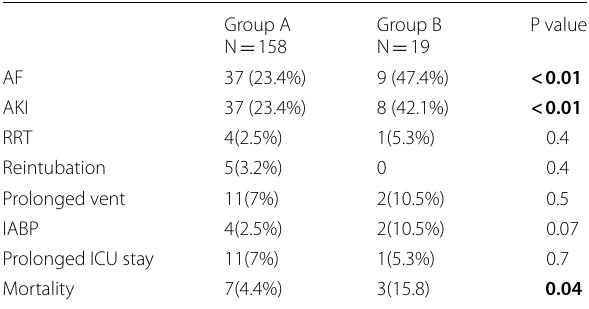
Table 1: Comparison of post-surgical outcomes for patients in Group A compared to those in Group